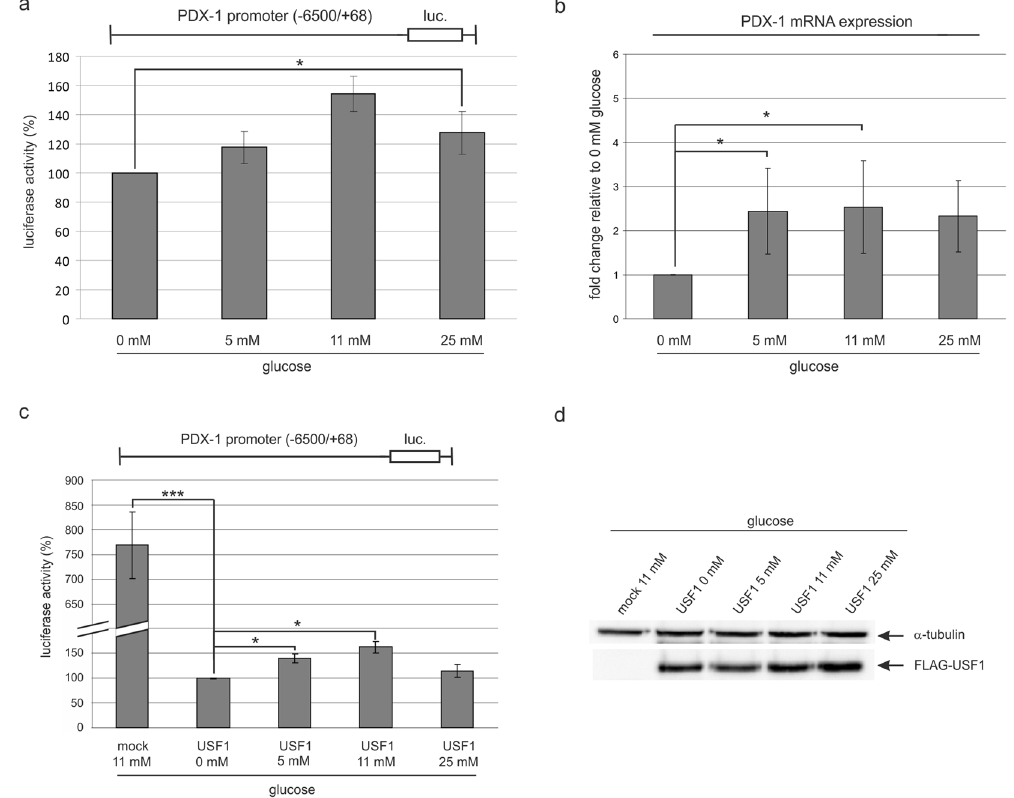
Figure 3. Influence of glucose on the transcription of the PDX-1 promoter of INS-1 cells. ( a ) INS-1 cells were transfected with the PDX-1 promoter construct − 6500/ + 68-STF-luc and starved overnight. The next day, cells were treated with 0 mM, 5 mM, 11 mM or 25 mM glucose and harvested after a period of 4 h. Luciferase activity was determined in triplicate; the activity in the cells treated with 0 mM glucose was set to 100%. Statistical analysis was performed by using Students t-test. * Significant difference p < 0.05. ( b ) INS-1 cells were starved overnight and the next day treated with 0 mM, 5 mM, 11 mM or 25 mM glucose and harvested after a period of 24 h for mRNA isolation with TRIzol ® Reagent. PDX-1 mRNA levels were detected semi-quantitatively by real-time RT-PCR. Fold change of PDX-1 mRNA expression relative to 0 mM glucose is displayed (mean ± SD, n = 3). ( c ) INS-1 cells were transfected with the PDX-1 promoter construct − 6500/ + 68-STF-luc and the USF1 expression plasmid. After overnight starvation, cells were treated with 0 mM, 5 mM, 11 mM or 25 mM glucose and harvested after a period of 4 hours. Luciferase activity was determined in triplicate; the activity in the 0 mM glucose treated cells was set to 100%. Statistical analysis was performed by using Students t-test. * Significant difference p < 0.05. ( d ) The corresponding Western blot analysis of the FLAG-tagged USF1 is shown beside the graph. Identification of FLAG-tagged USF1 was performed with the mouse monoclonal antibody FLAG M2 (F1804), and α -tubulin served as a loading control. Full-length blots are presented in Supplementary Figure